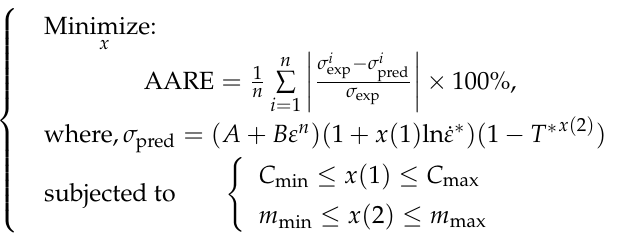
and ln˙ ε ∗ under the reference ( A + B ε n )